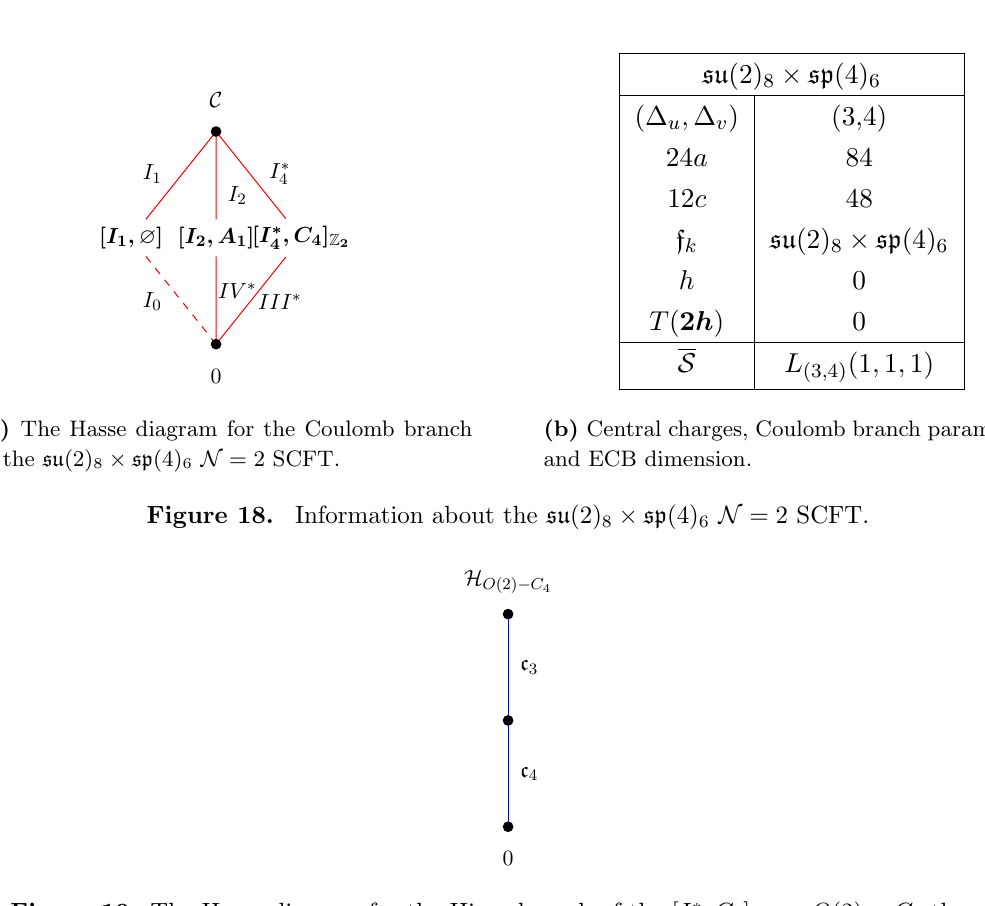
; C 4 ] Z or O (2) (cid:0) C 4 4 2